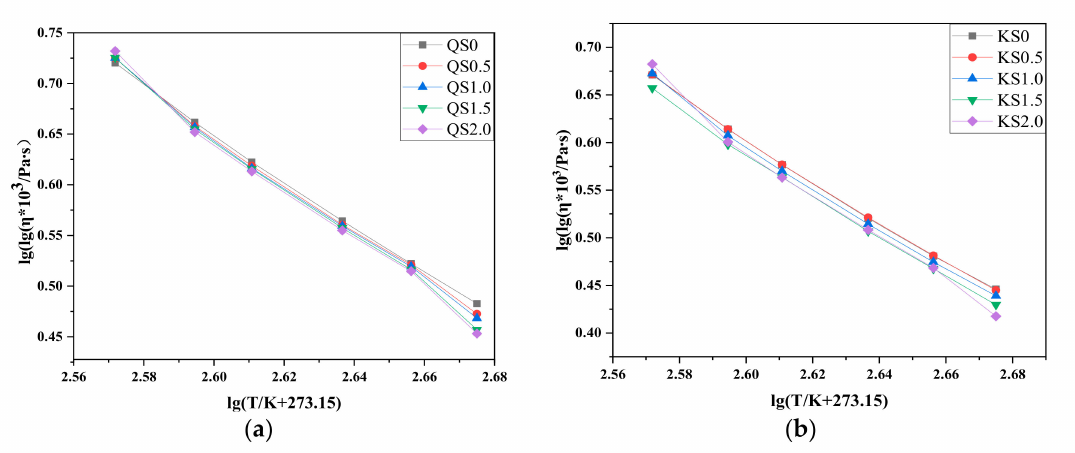
Figure 3. Viscosity-temperature relation curve of warm mix rubber asphalt: ( a ) QS; ( b ) KS. Table 3. Fitting result of Saal formula for viscosity-temperature relationship of warm mix rubber asphalt.